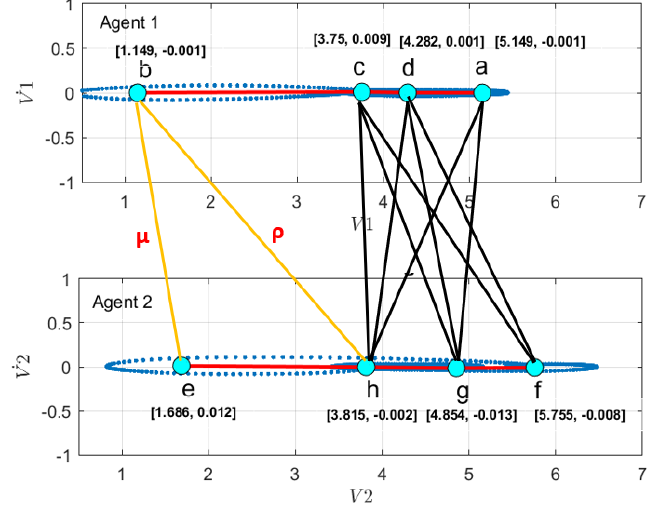
Figure 23. Joint vocabulary from the model M 2